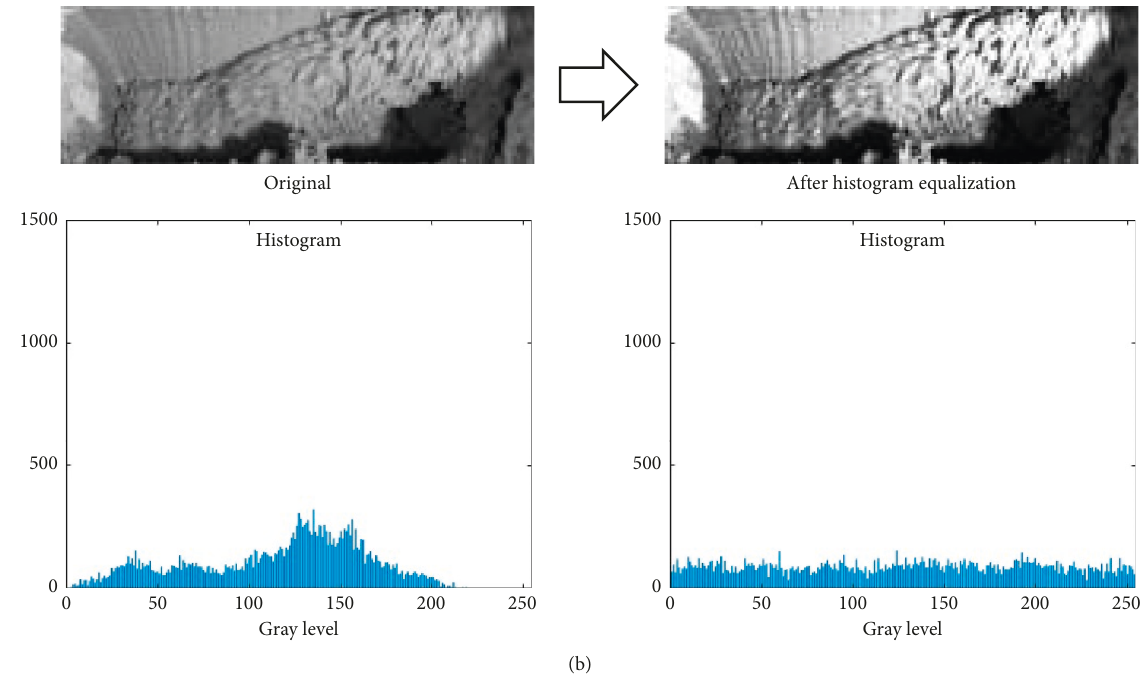
Figure 10: Histogram equalization: (a) dark condition; (b) light condition.